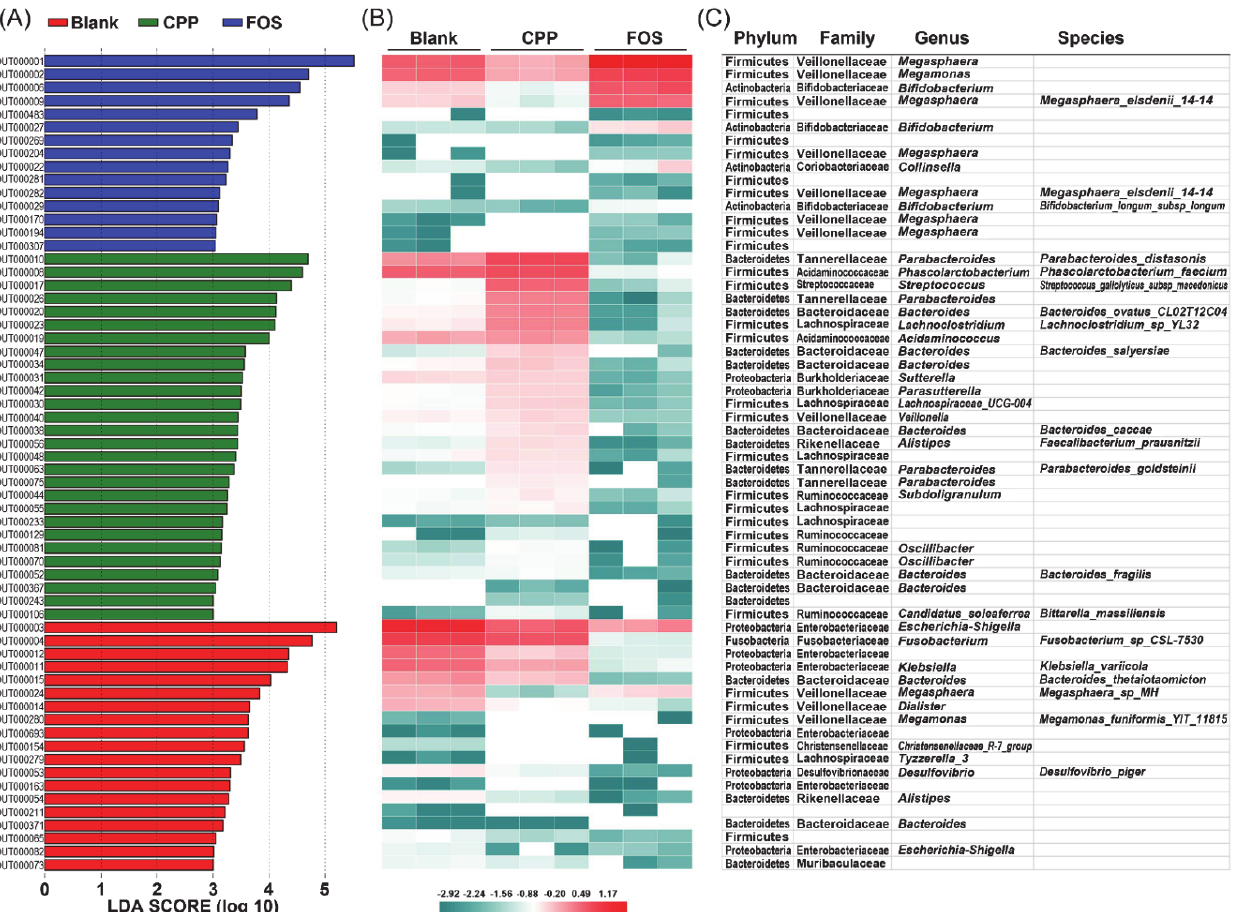
Figure 5. LEfSe analysis of microbiota from the blank, CPP and FOS groups at the OTU level (LDA score > 3.0). ( A ) Histogram of LDA scores computed for features differentially abundant. ( B ) Heatmaps of gut bacteria with the relative abundance (log 10 transformation) of OTUs based on the results of LEfSe. ( C ) Representative bacterial taxa information including phylum, family, genus, and species.